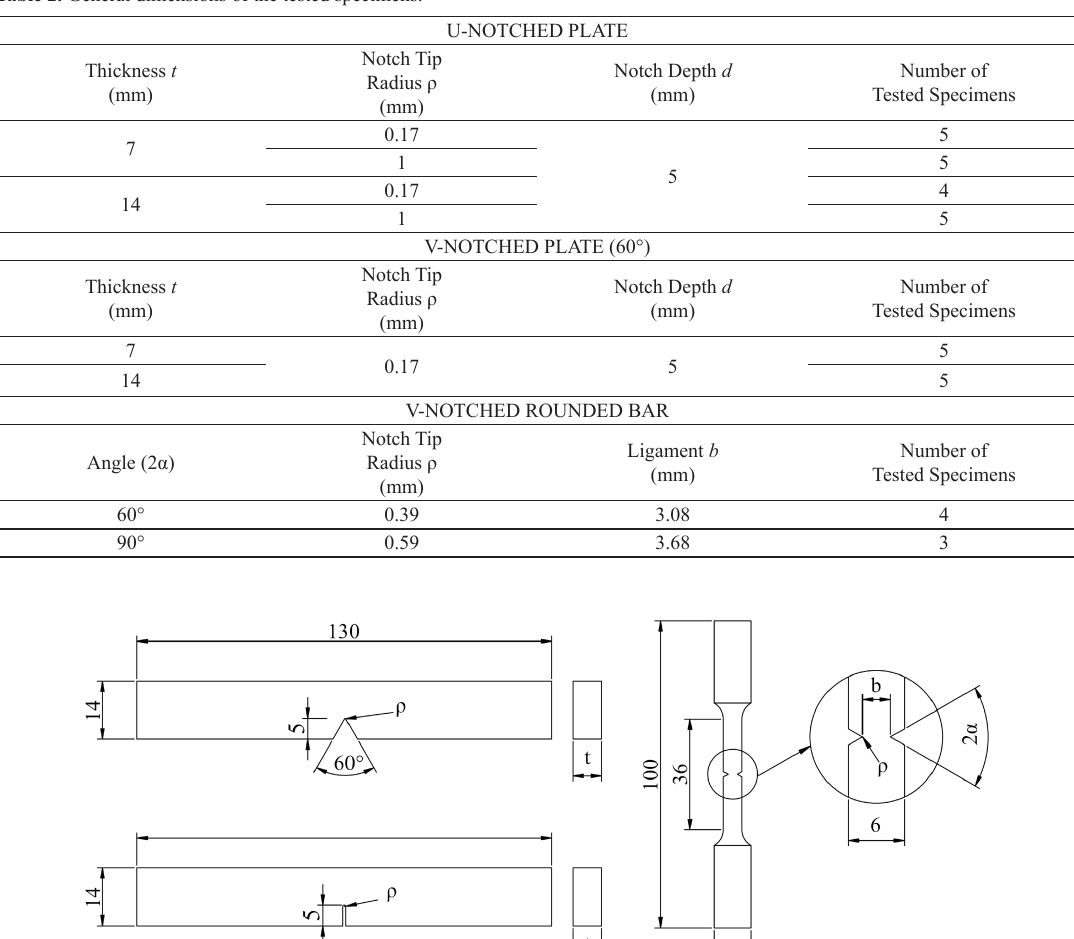
Table 2. General dimensions of the tested specimens.